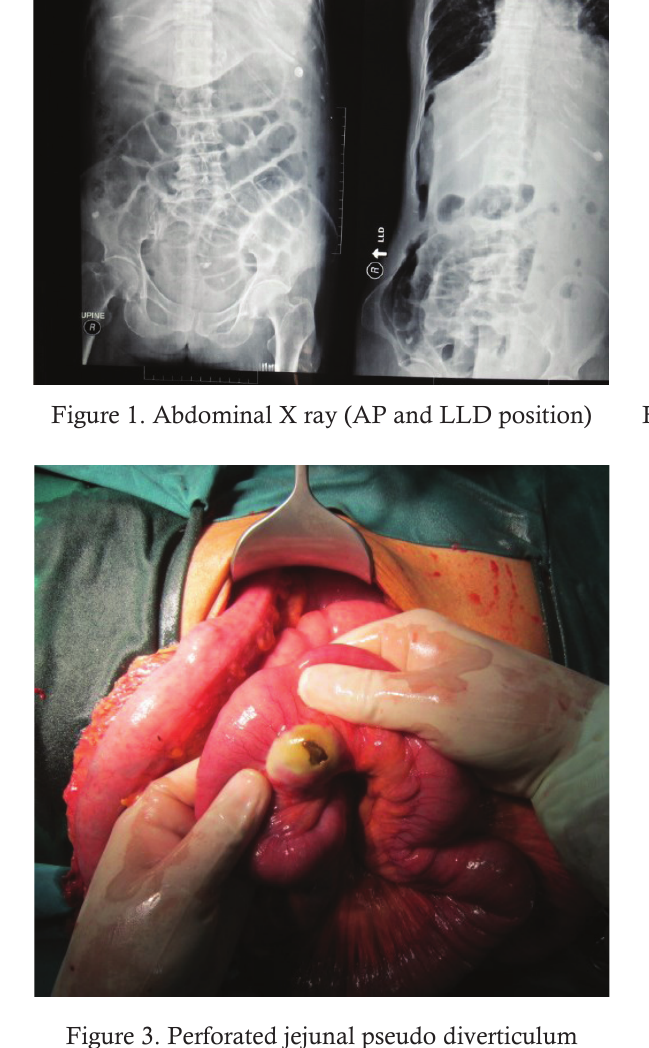
Figure 3. Perforated jejunal pseudo diverticulum Figure 4. Repaired of perforated jejunal pseudo